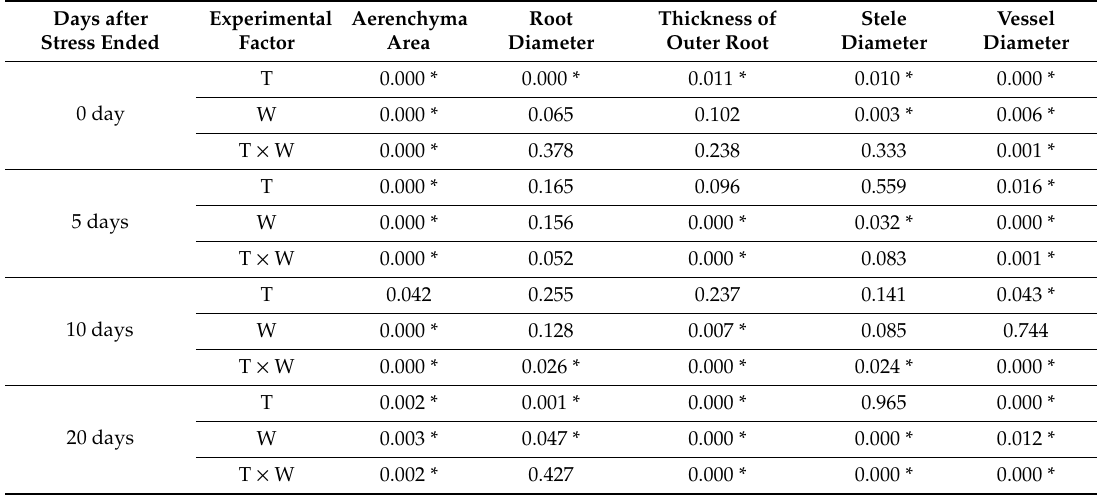
Table 1. p value of experimental factors and their interactions on anatomical parameters of rice roots. Days after Stress Ended